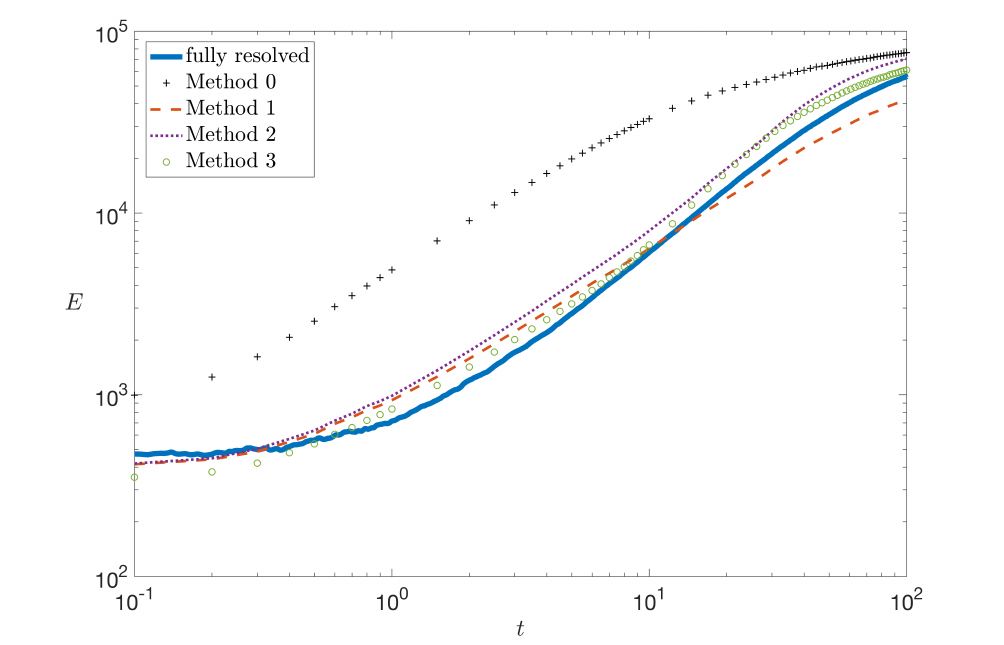
Figure 3. The dilution index, E , versus time for the fully resolved random walk model and the different versions of the upscaled model described in Section